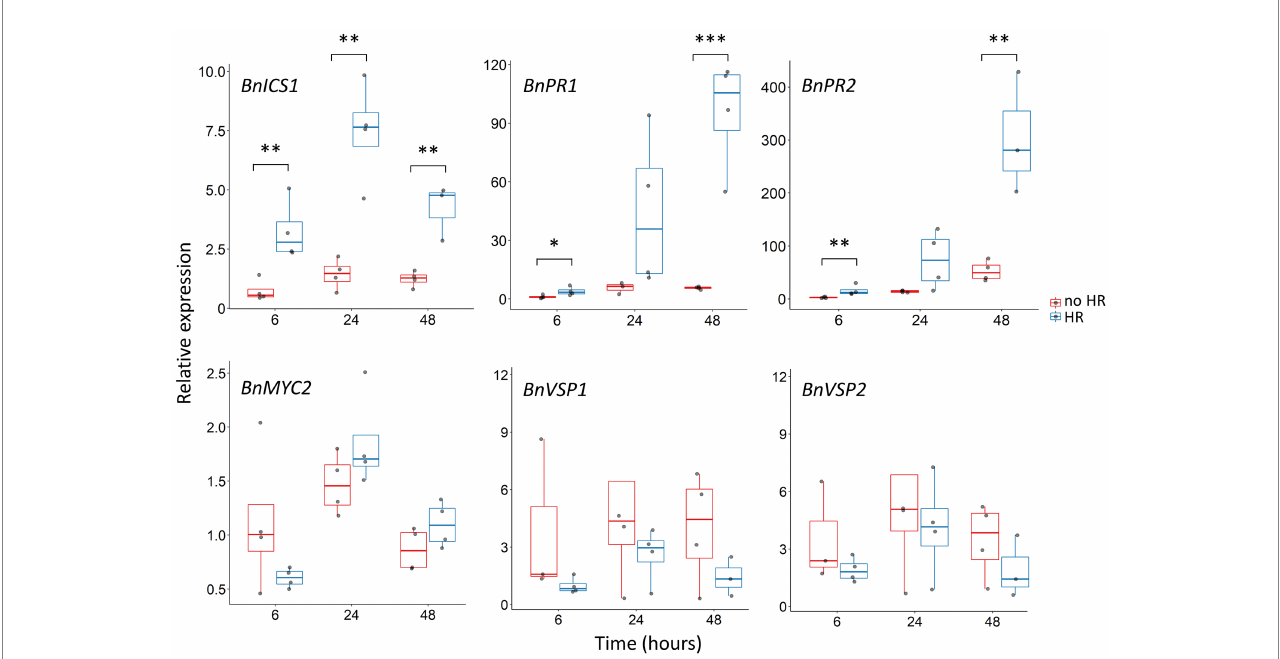
FIGURE 3 Expression of SA- and JA-related defense genes upon P. brassicae egg wash treatment in two different B. nigra accessions. Gene expression was measured with two treatments (egg wash, control), two accessions (no HR and HR) and at three time points (6, 24, and 48 h after treatment). HR phenotype of each plant was scored after sampling for RNA isolation. Gene expression was measured by qPCR-RT and normalized to housekeeping gene BnGADPH. Expression levels were calculated at each time point relative to control treatment (water droplets). Each treatment consisted of 4–5 biological replicates and is reported as boxplots. The height of the boxes in represents the first to the third quartile of the range; the horizontal line within the box is the median; the whiskers indicate the data minimum and maximum; and dots represent data points. At each time point, gene expression between the two accessions was compared (Welch’s T -test). Asterisks indicate different p -values within the same time point: ** <0.01, *** <0.001, no asterisks indicate no significant